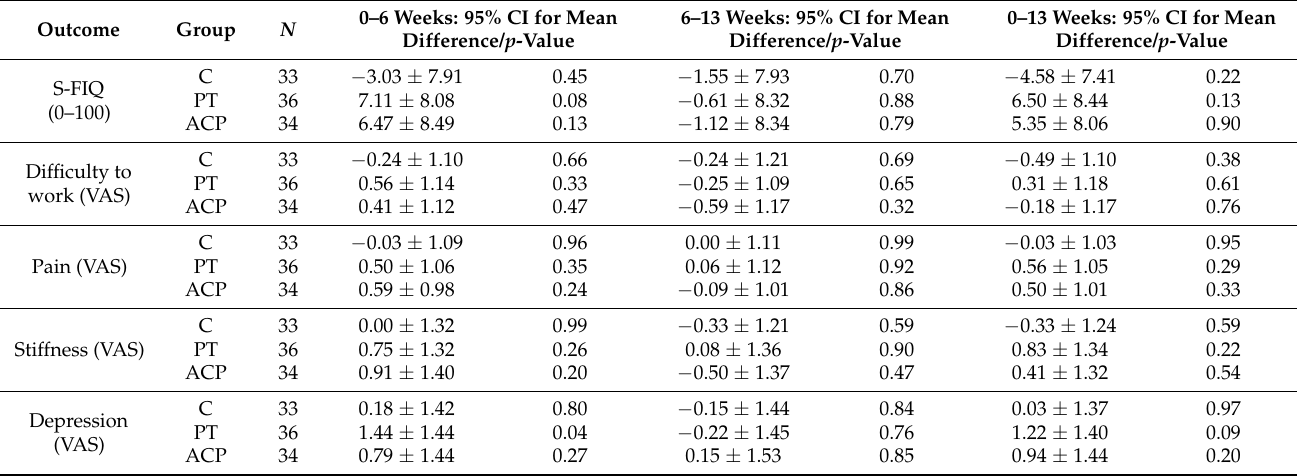
Table 4. Changes between weeks 0 and 6, 6 and 13 and 0 and13 for each group: 95% CI for the mean difference and p -value (derived from the mixed-model